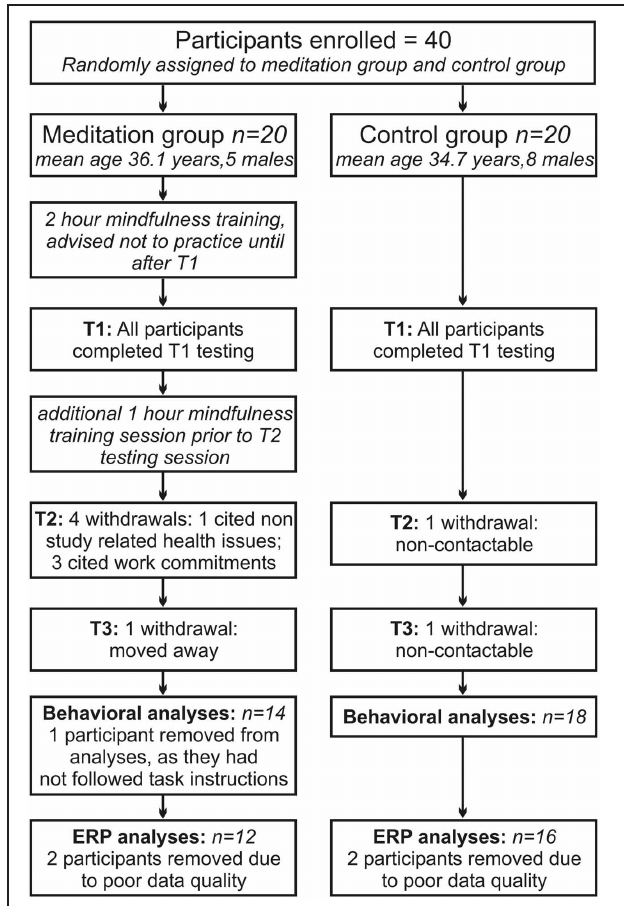
FIGURE 1 | Flow of participants through the study. From randomly allocating 20 participants to each group, for the final analysis 12 participants remained in the meditation group and 16 in the control